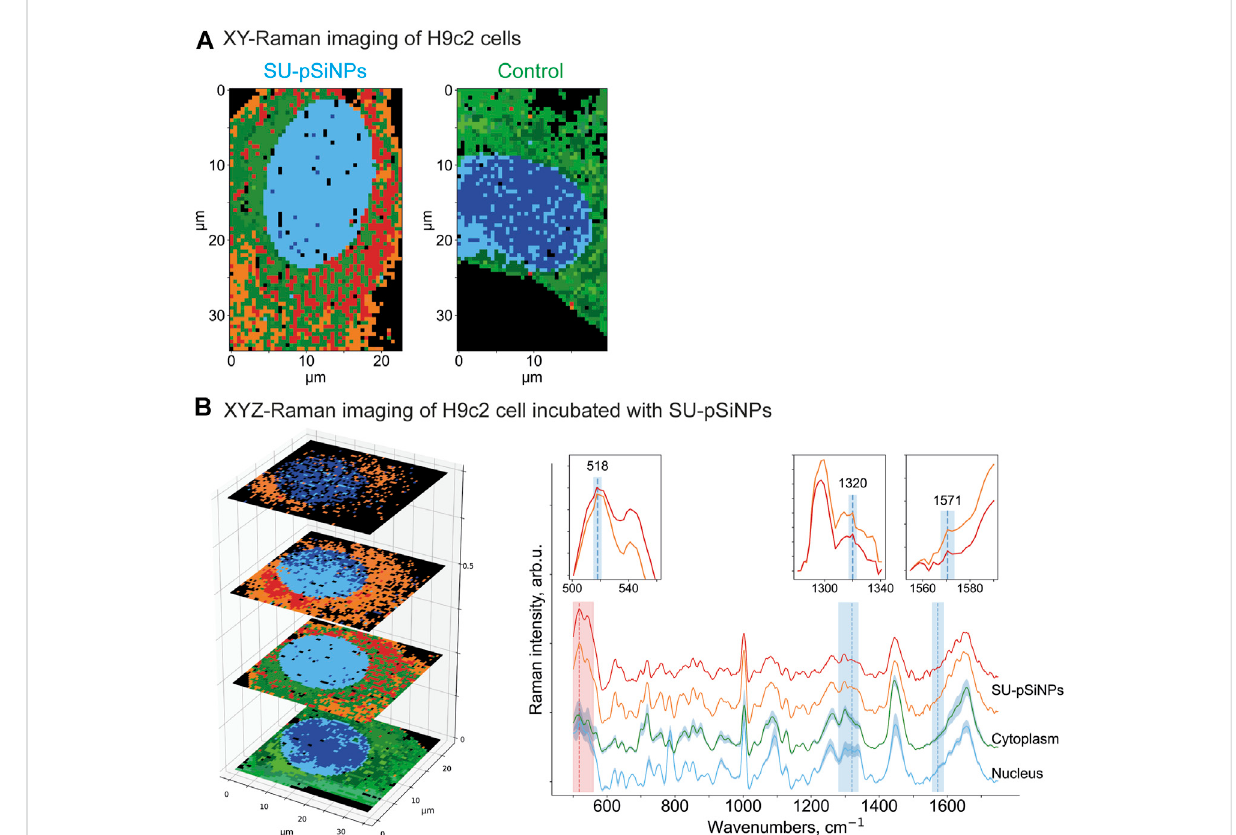
FIGURE 5 (A) XY- and (B) XYZ-Raman micro-spectroscopy images of a H9c2 cell incubated with 20 μ M of SU loaded in pSiNPs for 24 h [ (A) , left] and of a control H9c2 cell [ (A) , right]. After data preprocessing, HCA clustering was applied to distinguish the following main components: pure cytoplasmic components (multiple green colors), nucleus (multiple blue colors), and red and orange clusters containing — next to cytoplasmic signal — SU and nanocontainer-speci fi cpeaksat518 cm − 1 forpSiNPs,and1320 cm − 1 and1571 cm − 1 forSU,respectively.Theclusterswereplottedwithstandard deviations shown as